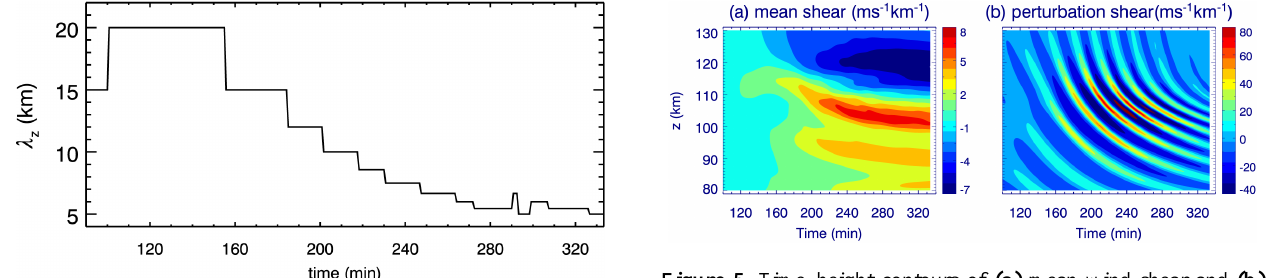
Figure 5. Time–height contours of (a) mean wind shear and (b) perturbation wind shear located at the midpoint of the horizontal computation domain for the case